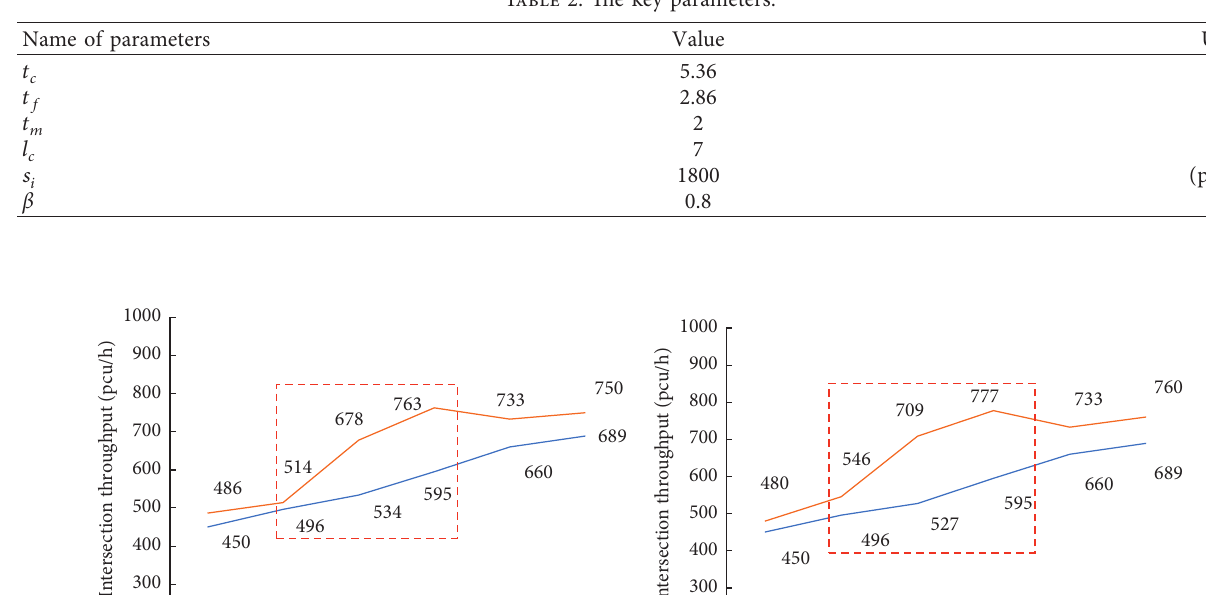
Table 2: The key parameters.